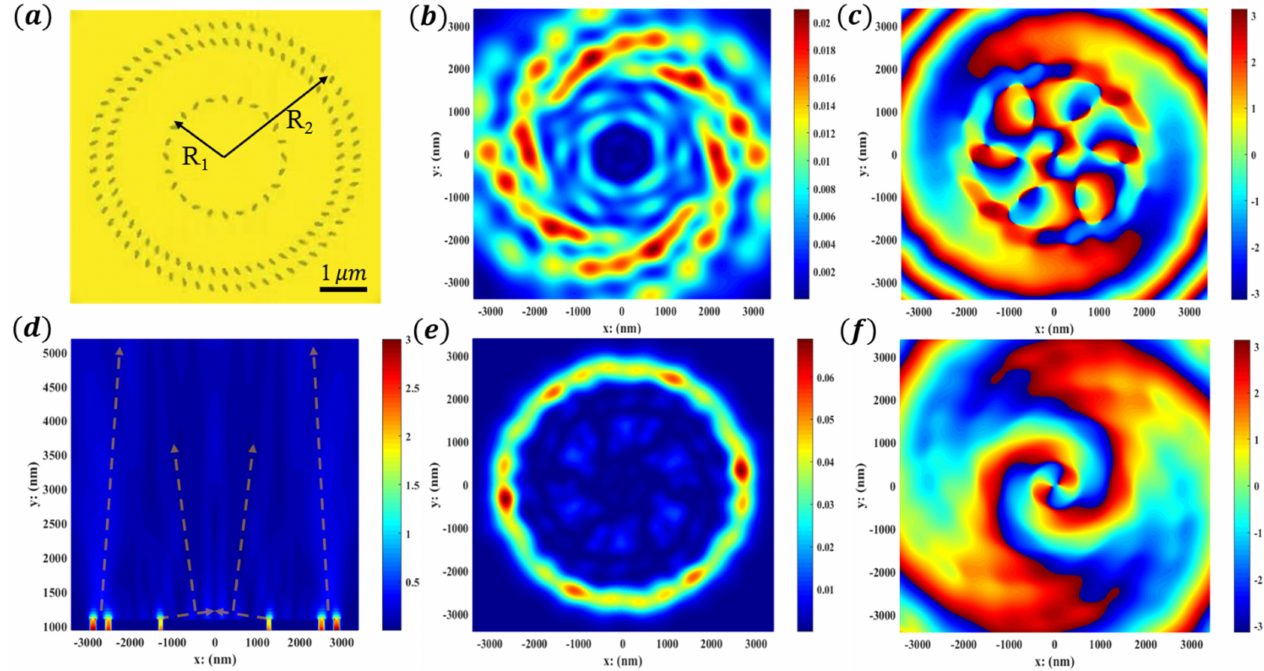
Figure 6. Realization of homologous bi-channel OVs in the near field and far field. ( a ) The array distribution of metal elliptical nanoholes. ( b , c ) Focal ring energy and phase distributions of near-field high-order ( l = 6) OV at z 2 = 1500 nm. ( d ) The electric field distribution of scattered light on the X-Y plane, with the metasurface at the bottom. The dotted lines show the propagation path of OVs. ( e , f ) Focal ring energy and phase distributions of far-field low-order ( l = 2) OV at z 3 = 5000